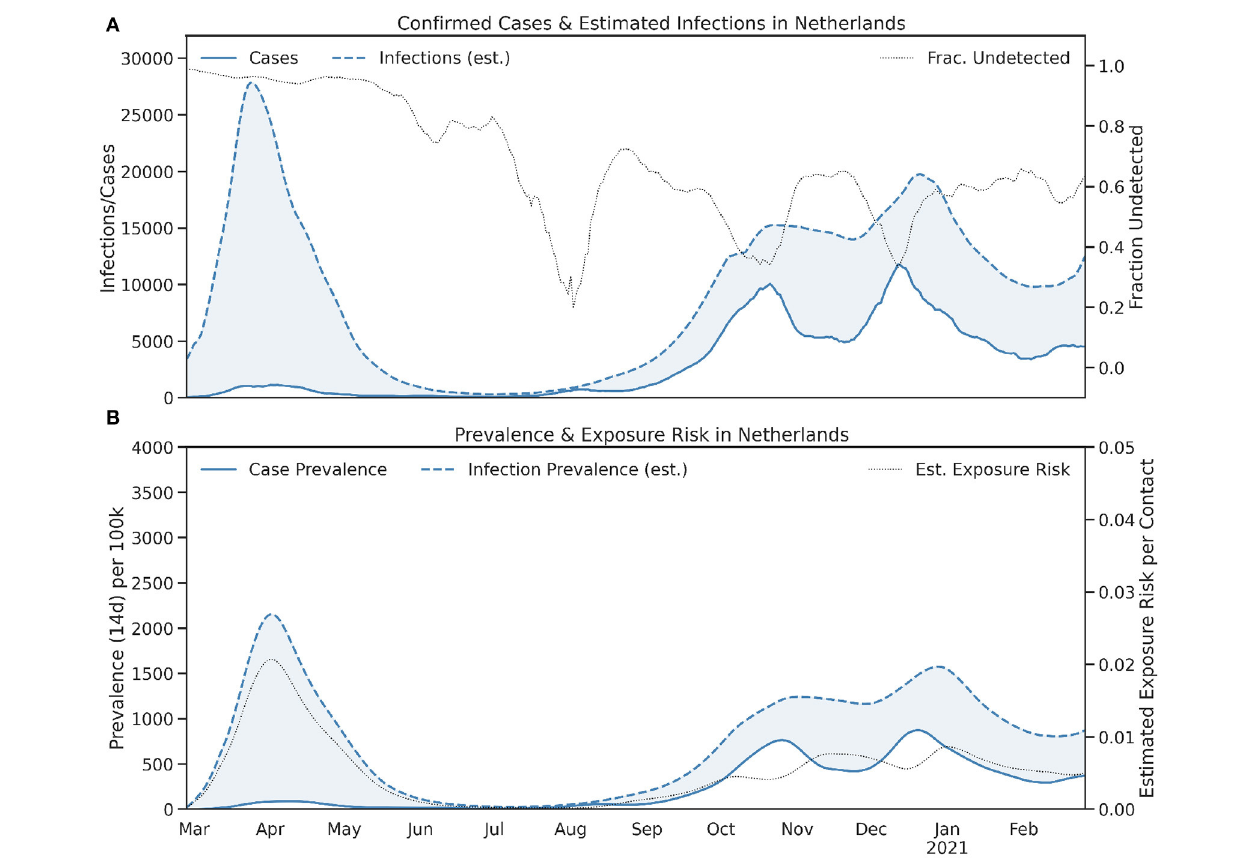
FIGURE 2 | The (A) daily and (B) 14-day totals (prevalence) of confirmed cases and estimated infections in the Netherlands. In (A) the fraction of undetected infections and in (B) the estimated exposure risk, are also shown.